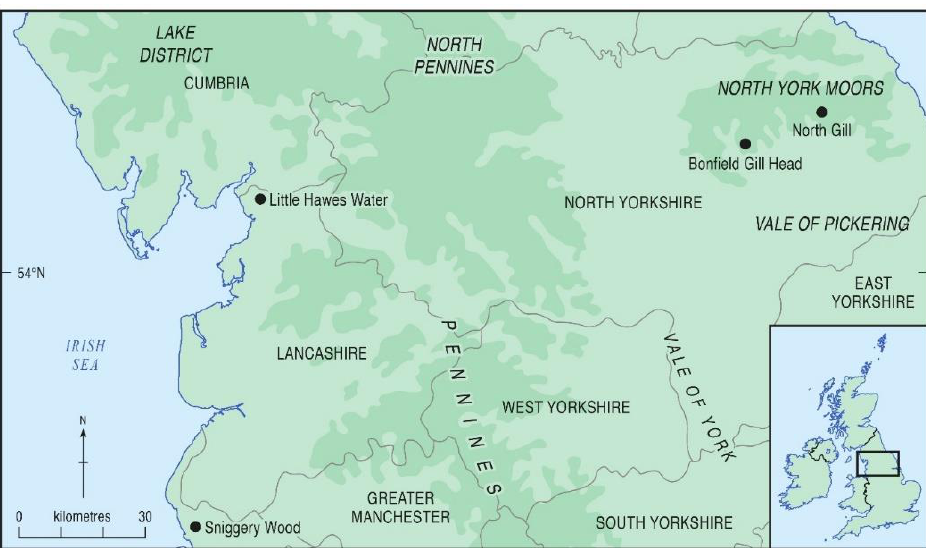
Figure 1. Location of the four sites studied in this paper. North Gill and Bonfield Gill Head are at about 350 m above sea level on the North York Moors in northeast North Yorkshire. Little Hawes Water and Sniggery Wood are lowland sites in North Lancashire and Merseyside, respectively. The dark green areas are land above 200 m altitude.